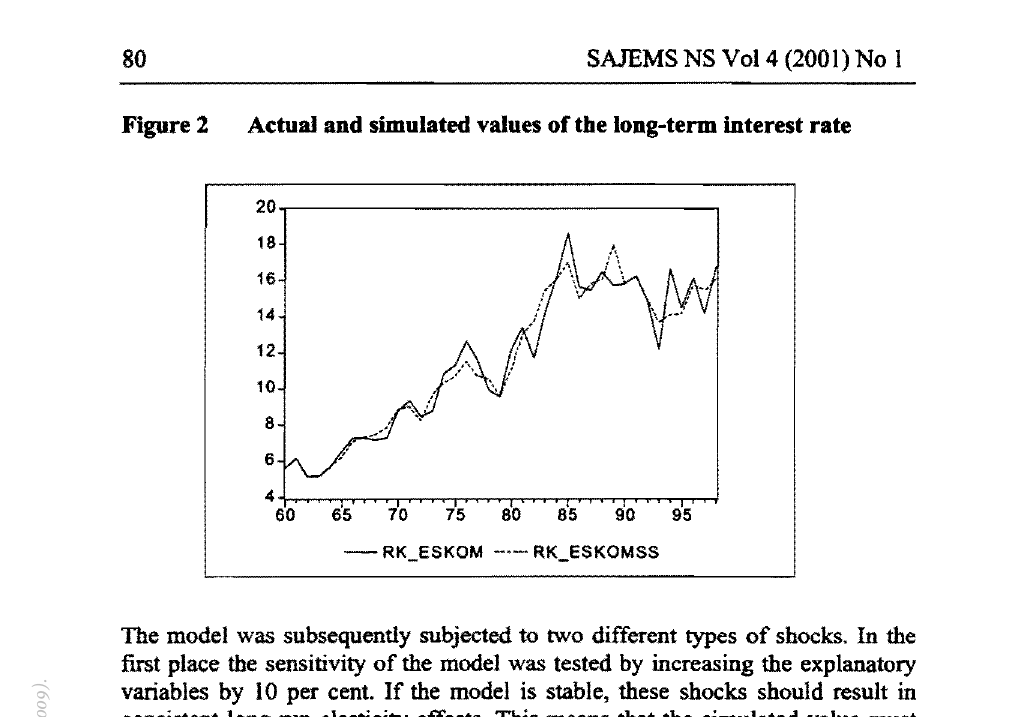
Figure 2 Actual and simulated values of tbe long-term interest